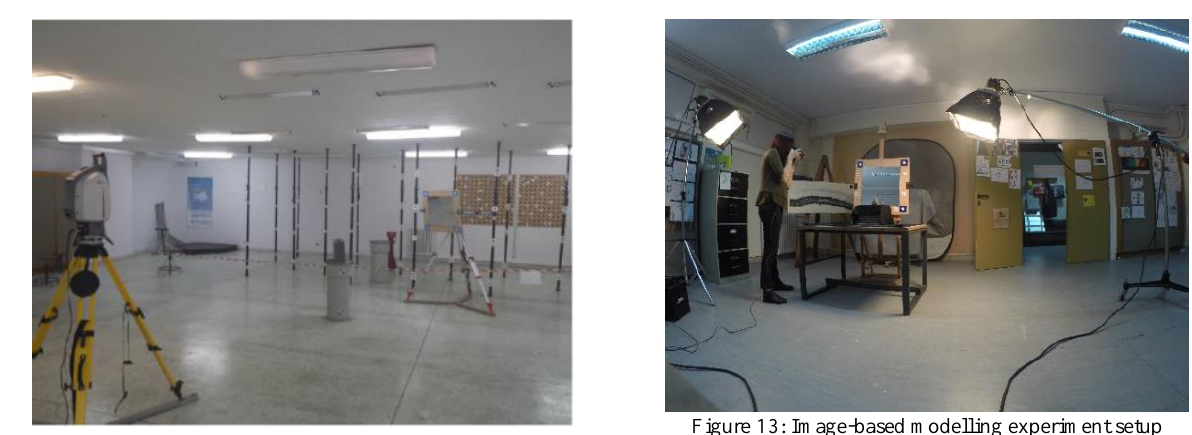
Figure 11: Laser scanner experiment setup